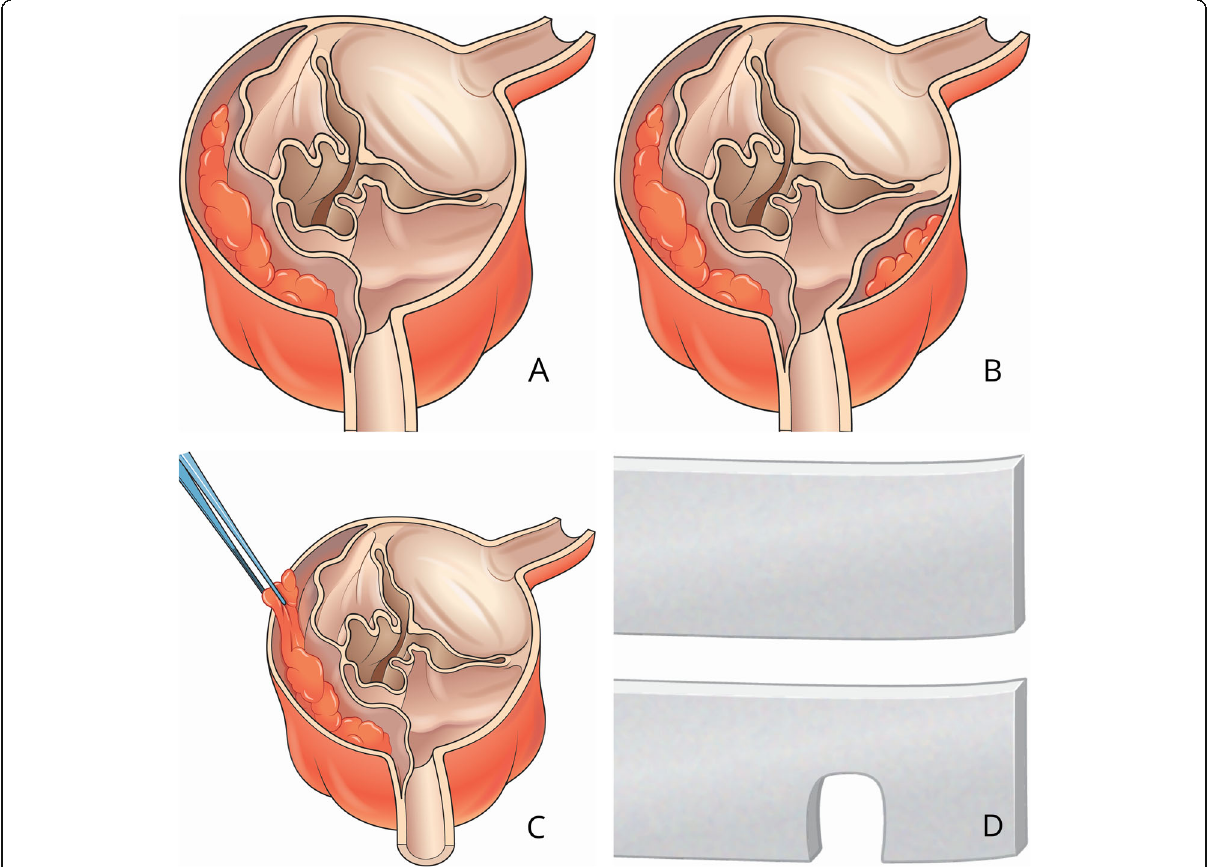
Fig. 1 Operative sighting of the aortic root and preparation for the